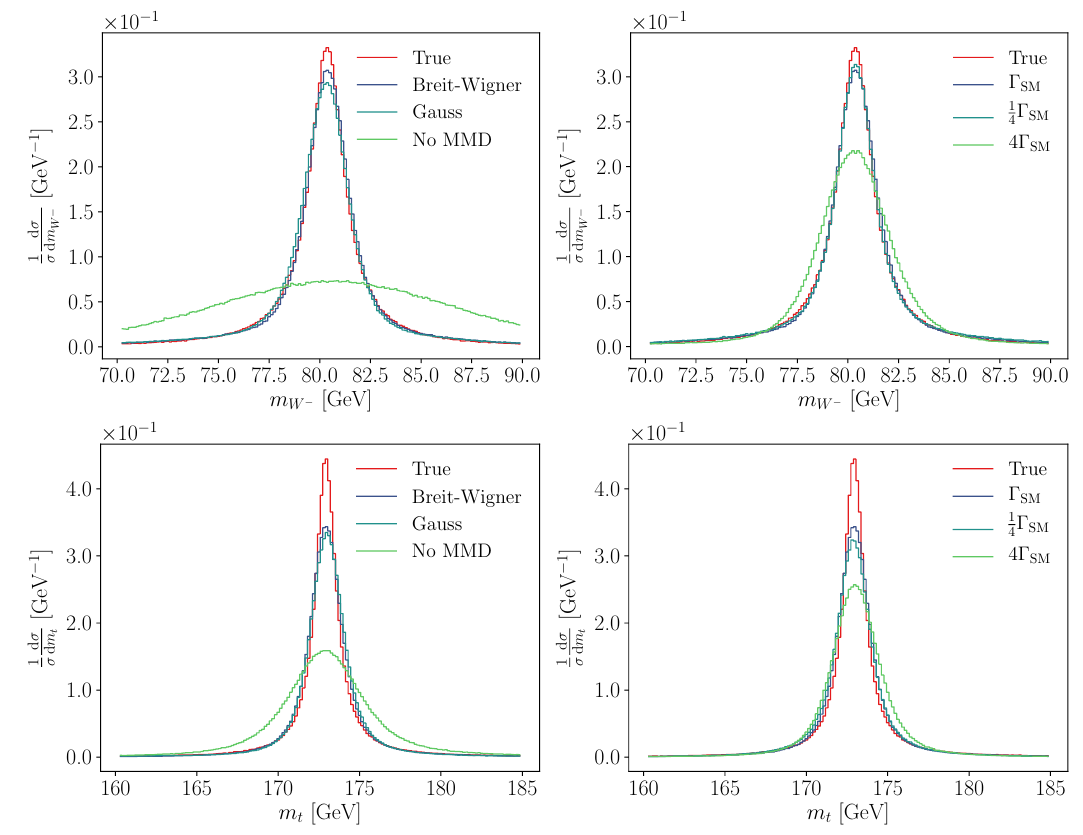
Figure 7: Comparison of different kernel functions (left) and varying widths (right) and their impact on the invariant mass of W boson (top) and top quark